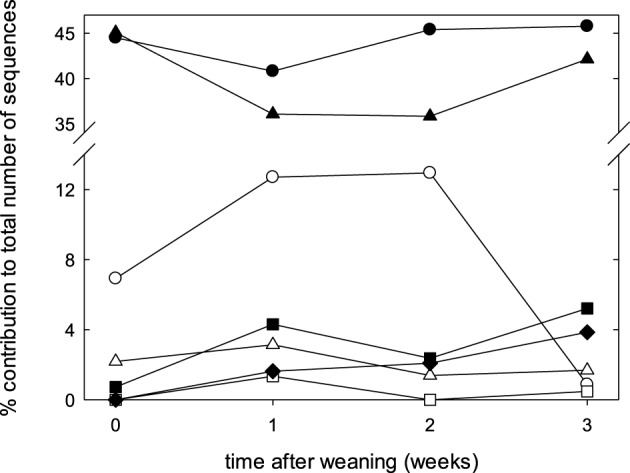
Composition of fecal microbiota at the phylum level at weaning, and during the first 3 weeks after weaning. Data represent the median proportions of each phylum as determined by the RDP (Ribosomal Database Project) classifier. The phyla are represented by symbols as follows: ●, Bacteroidetes; ▴, Firmicutes; , Proteobacteria; Δ, Spirochaetes; ■ , Tenericutes; , Planctomycetes; ♦, unassigned.